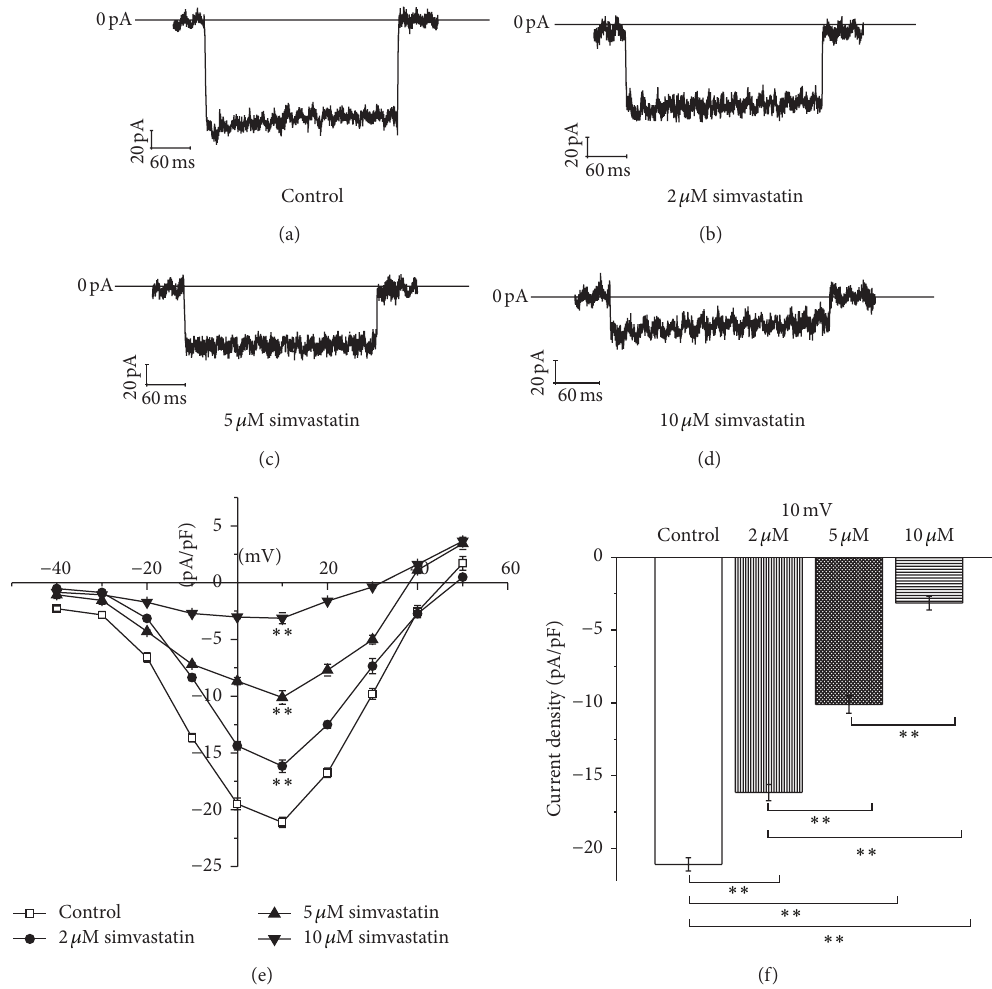
current Ca-L Ca-L Ca-L